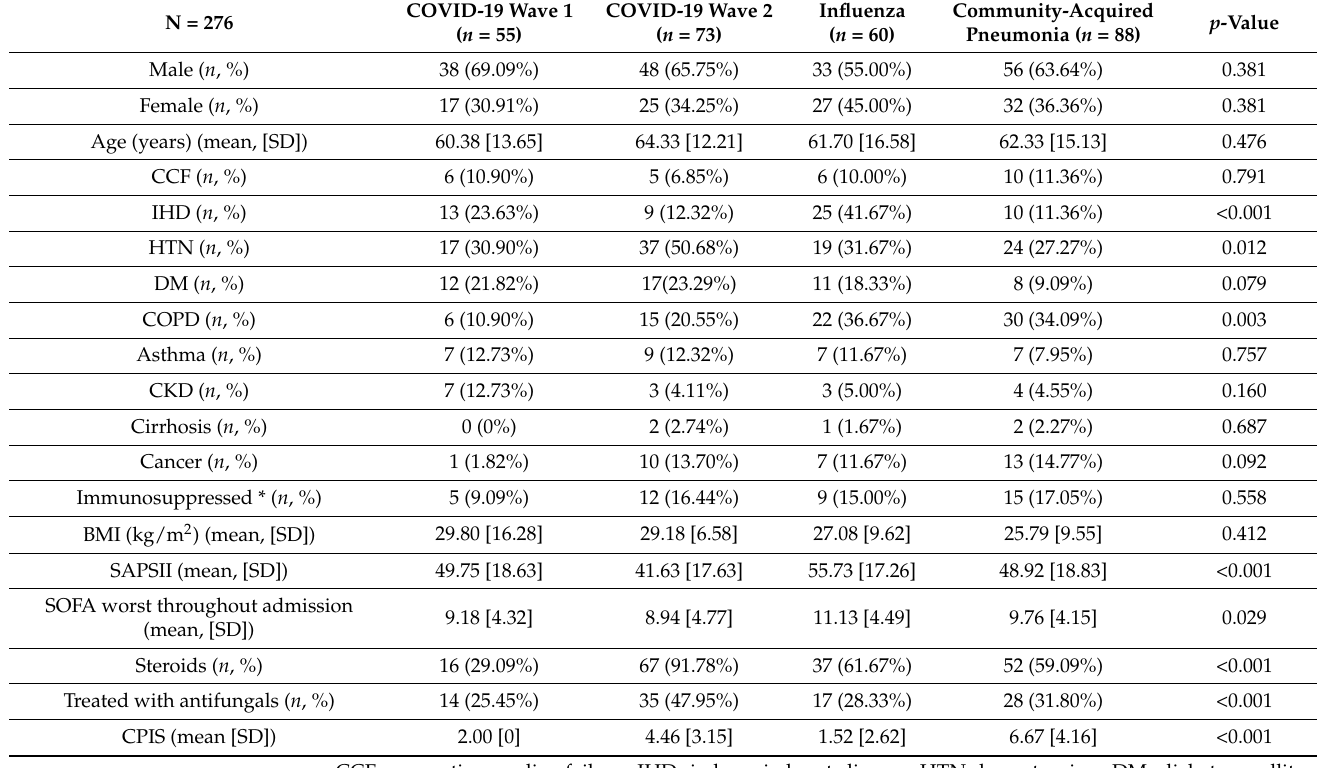
Table 1. Clinical Characteristics—co-morbidities, prognostic scores, treatment.